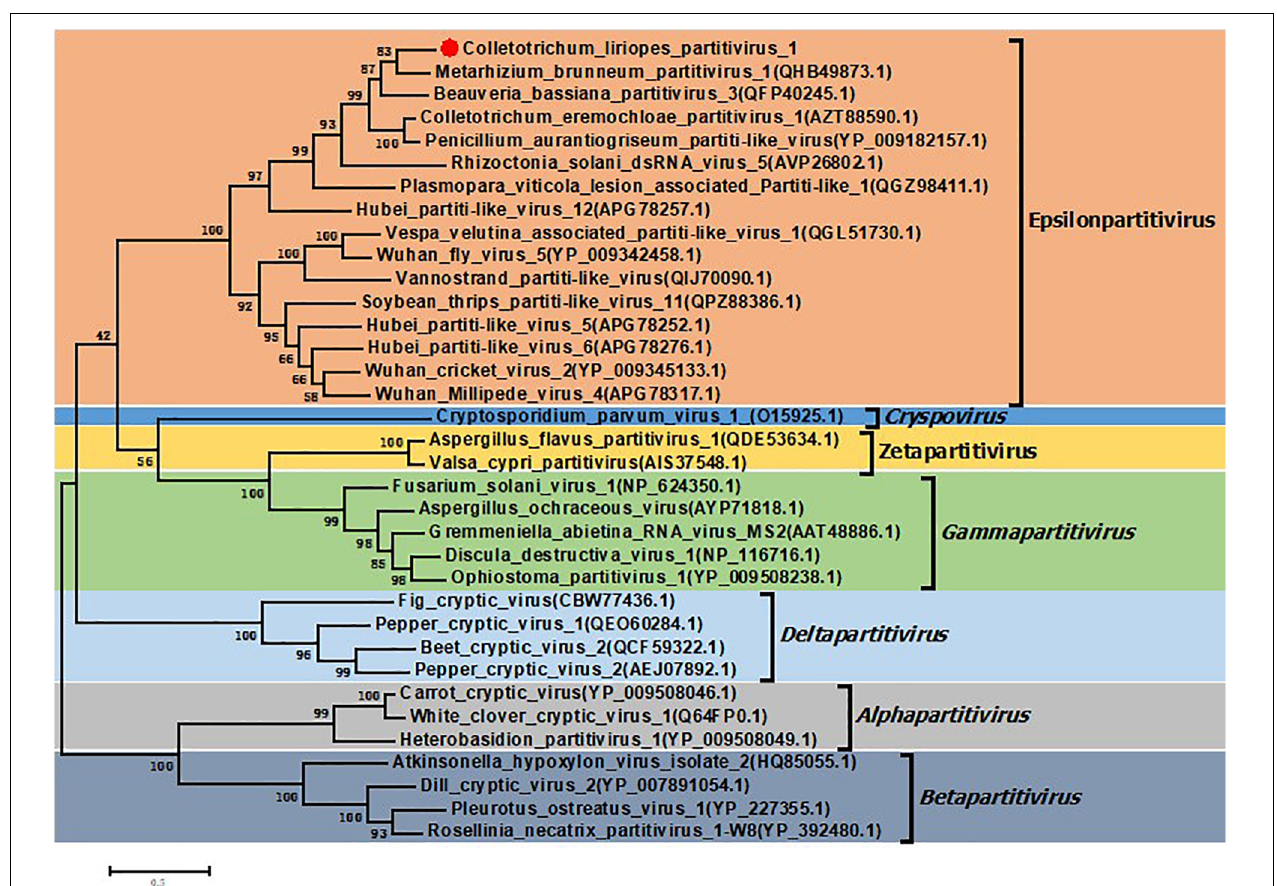
FIGURE 4 | Phylogenetic analysis of ClPV1. Phylogenetic trees were generated based on the amino acid sequences of the RdRp of ClPV1 and other selected partitiviruses, respectively. The phylogenetic tree was constructed using maximum likelihood method with bootstrapping analysis of 1000 replicates. ClPV1 was indicated in the phylogenetic tree. The scale bars mean the estimated number of substitutions per 100 amino acids.